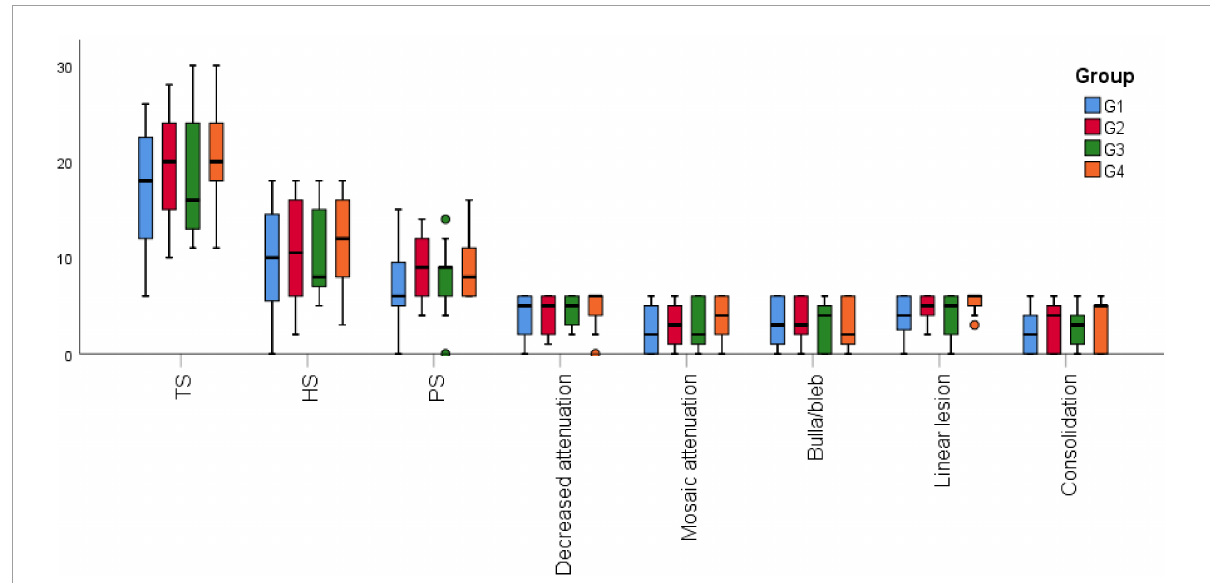
FIGURE1 High-resolution computed tomography (HRCT) scores among the different combinations of phenotypes. G1, parenchymal disease; G2, parenchymal disease + PH; G3, parenchymal disease + TBM; G4, parenchymal disease + PH + TBM; HS, hyperaeration score; PS, parenchyma score; TS, total